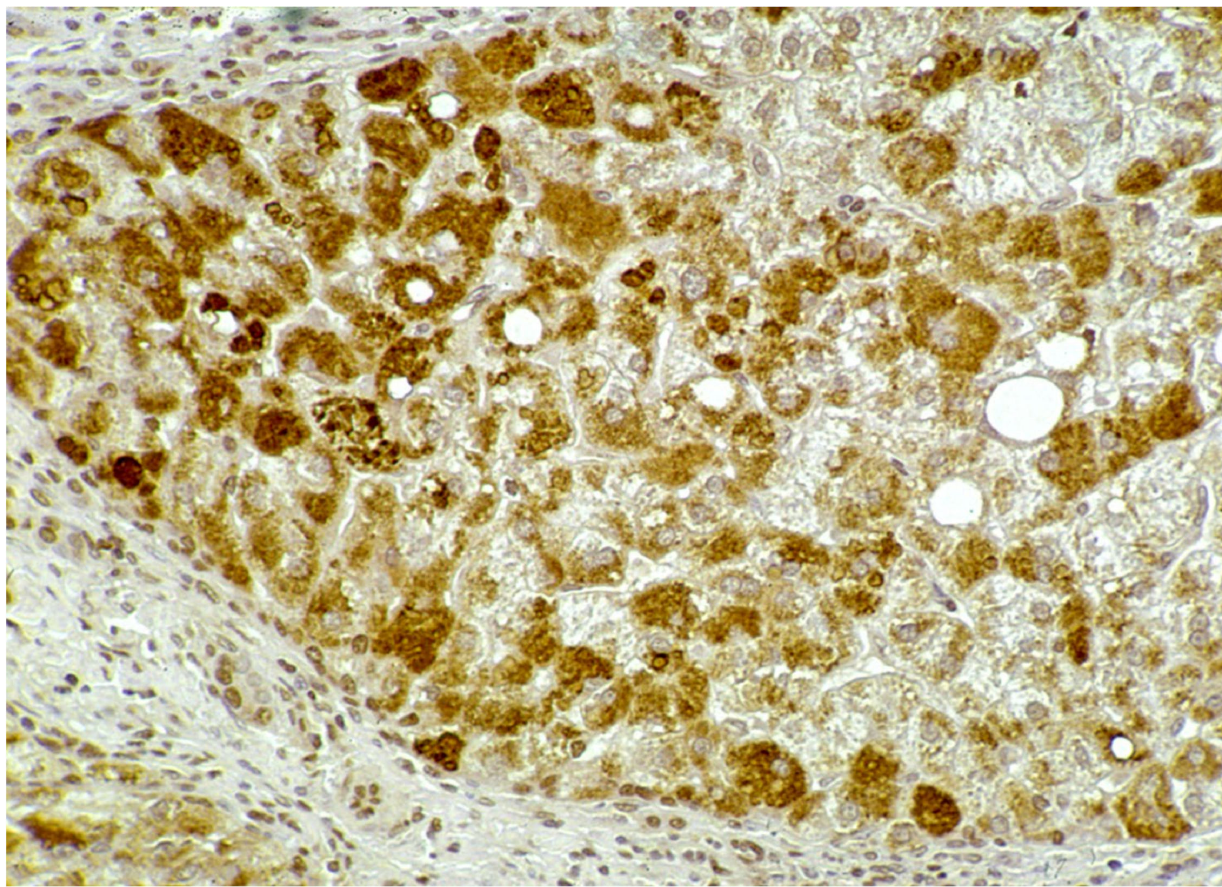
Figure 14. HHHS cirrhotic liver specimen. Hepatocytes in a parenchymal cirrhotic nodule contain inclusions specifically immunoreactive to an anti-gamma chain fibrinogen antibody (monoclonal FGG immunostaining × 100). On immunostaining, HHHS and Pi ZZ patients show a similar pattern especially in the cirrhotic stage. Hepatocytes show mainly type I positivity, but type II can be observed in some areas of the nodules (Figure